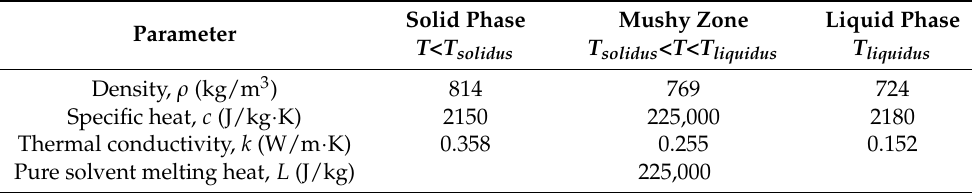
Table 2. The material properties of